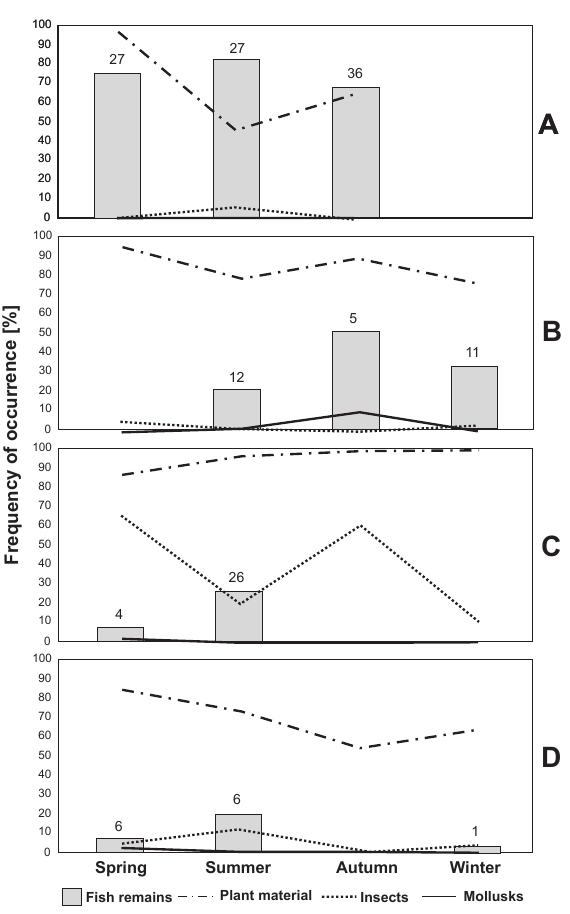
Figure 4. The frequency of occurrence of the main food types found in the gut contents of the Scardinius acarnanicus speci- mens collected during the four seasons from A : Lake Trichonis (with light), B : Lake Trichonis (without light), C : Lake Ozeros and D : Lake Amvrakia. The numbers of the Scardinius acarnan- icus individuals with fish remains in their gut content are